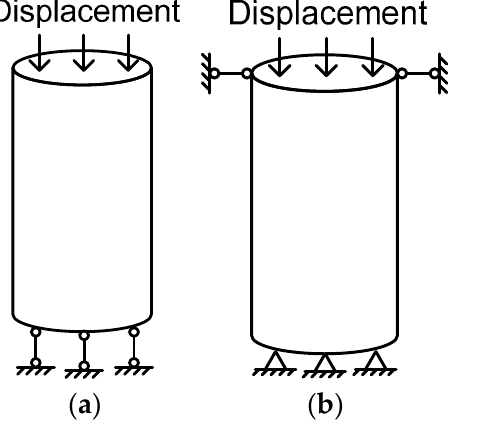
Table 2. The material parameters of rock adopted in numerical simulation.